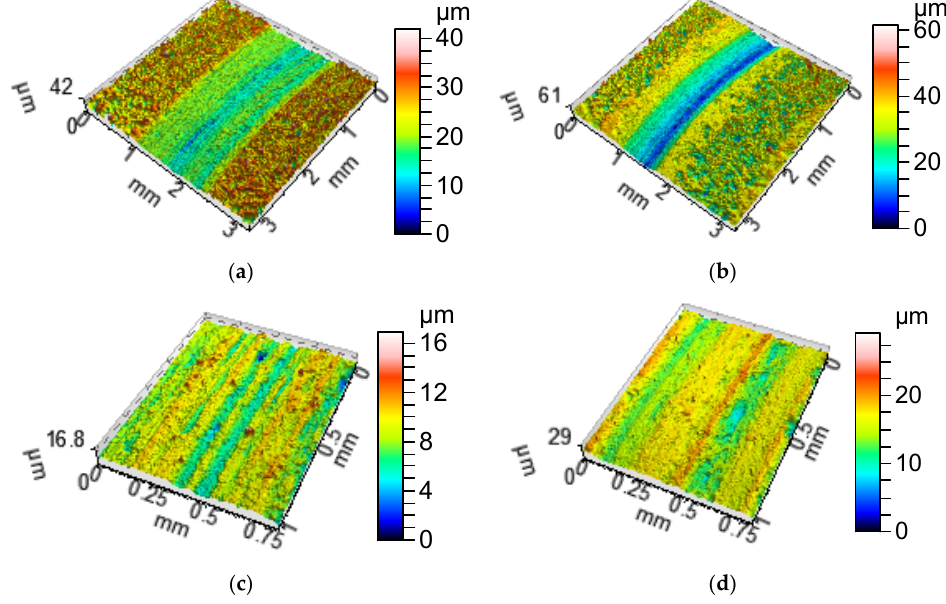
Figure 6. Isometric views of the discs S4 ( a ) and S6 ( b ) after tribological tests and details of their worn surfaces S4 ( c ), S6 ( d ).